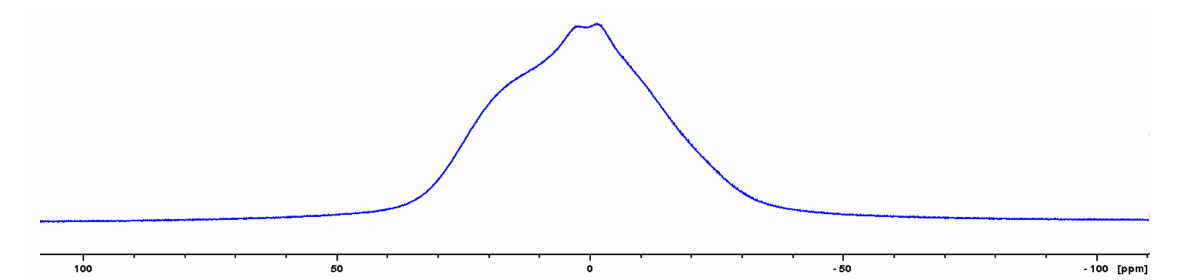
Figure 7. Solid state 1 H NMR spectrum of oligomer III.